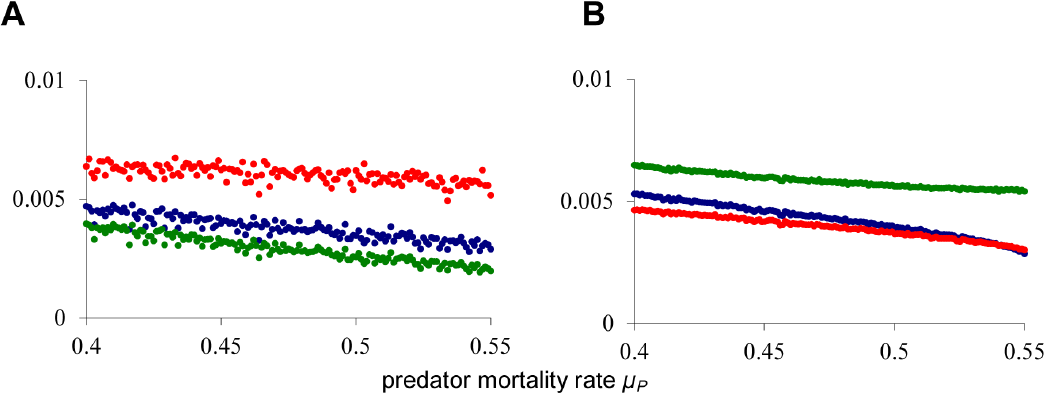
Figure 6. Early warning signals with correlated noise and discrete noise. Coefficient of variation and autocorrelation are monitored for increasing predator death rate towards the catastrophic collapse at m P < 0.553. Bifurcation procedure, parameters and colors are identical to Figure 2. ( A ) Coefficient of variation when pink noise (1/f correlated noise) is added to the death rate of the adult population. ( B ) Coefficient of variation when discrete white noise is applied directly to the adult population numbers after each time step.